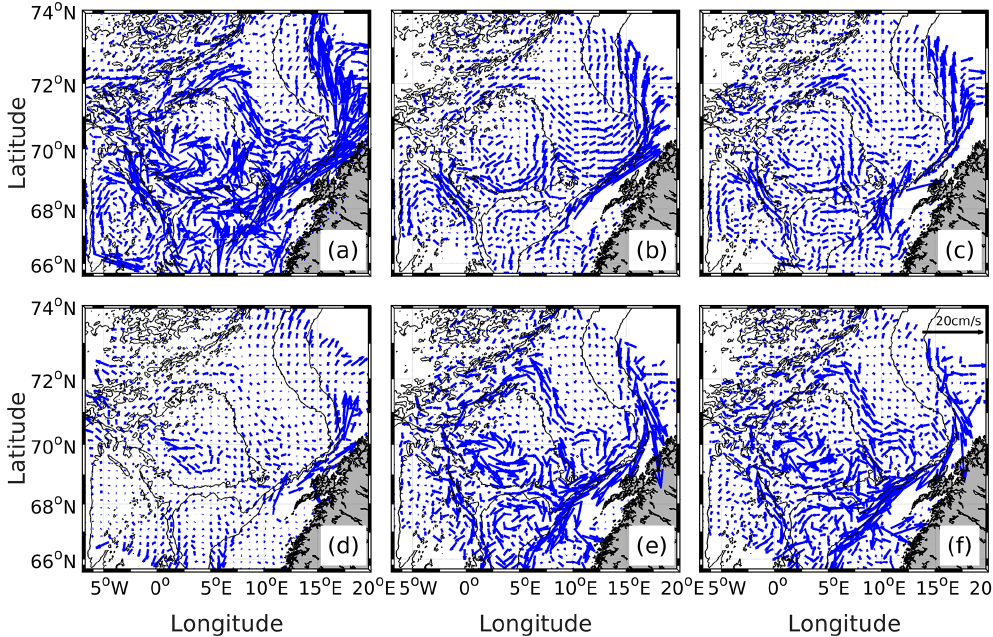
Figure 8. Averaged velocity fields at 200m from ROMS or 2D drifters. (a) Eulerian mean flow from the ROMS model at 200m averaged between 1996 and 2000; (b) drift of cyclonic ridges; (c) drift of anticyclonic ridges. Residual flow from (d) AF drifters, (e) cyclonic ridges and (f) anticyclonic ridges. Residuals are obtained by removing the Eulerian mean flow (a) . Scale of the arrows is given in upper right in (f) and is the same for all panels